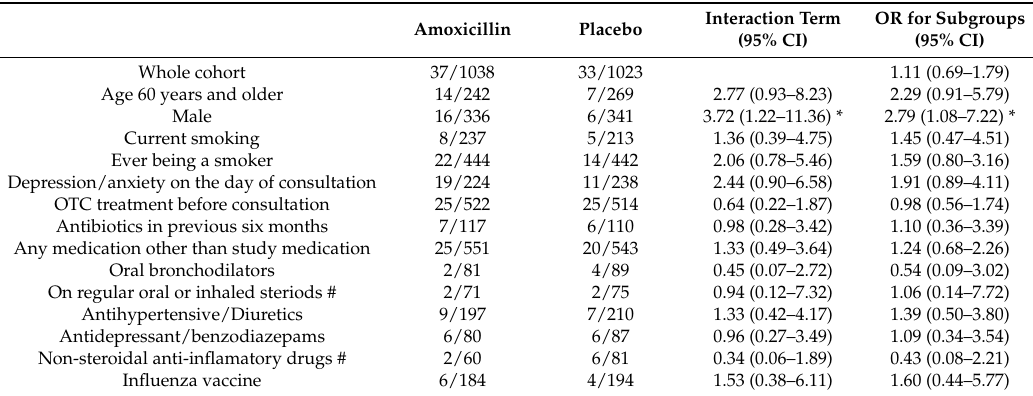
Table 4. Rash in the whole cohort and in subgroups of adult patients in the first week after presenting to primary care with a LRTI and allocation to amoxicillin or